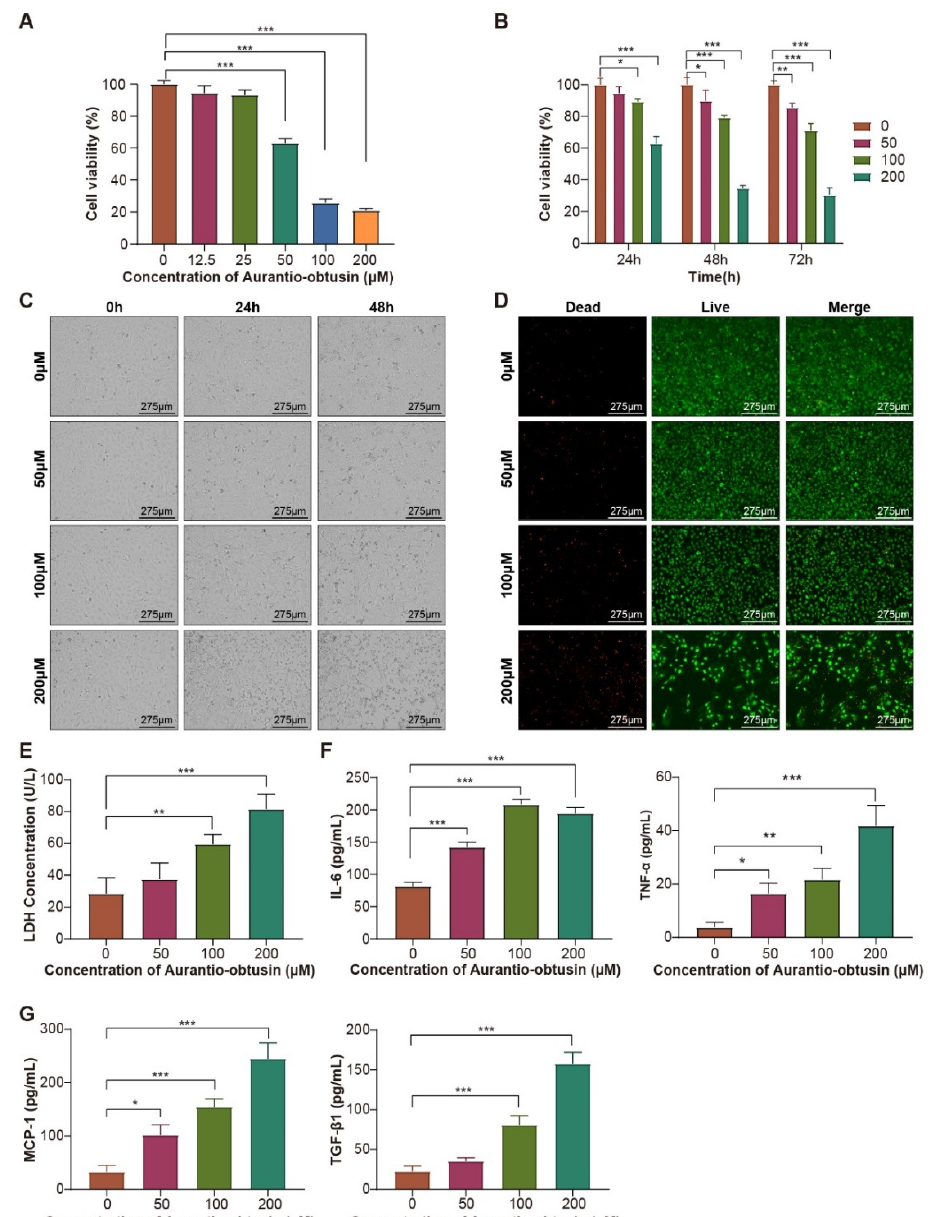
Figure 3. Cytotoxic effects of AO on glomerular endothelial cells. ( A ) CCK-8 assay of HRGEC viability in 96-well plates. ( B ) CCK-8 assay of HRGECs viability on the microfluidic chip. ( C ) Morphological changes in HRGECs after exposure to AO on the microfluidic chip were observed using a bright-field microscope. ( D ) Fluorescence images of live/dead staining of HRGECs on the chip after exposure to AO. The live cells were stained green and the dead cells were stained red. ( E ) LDH leakage assay in HRGECs. ( F ) AO treatment increased the expression of pro-inflammatory cytokines IL-6 and TNF- α . ( G ) AO treatment increased the expression of cytokines TGF- β 1 and MCP-1. The data are presented as means ± standard deviation. n = 3, * p < 0.05, ** p < 0.01, *** p < 0.001.